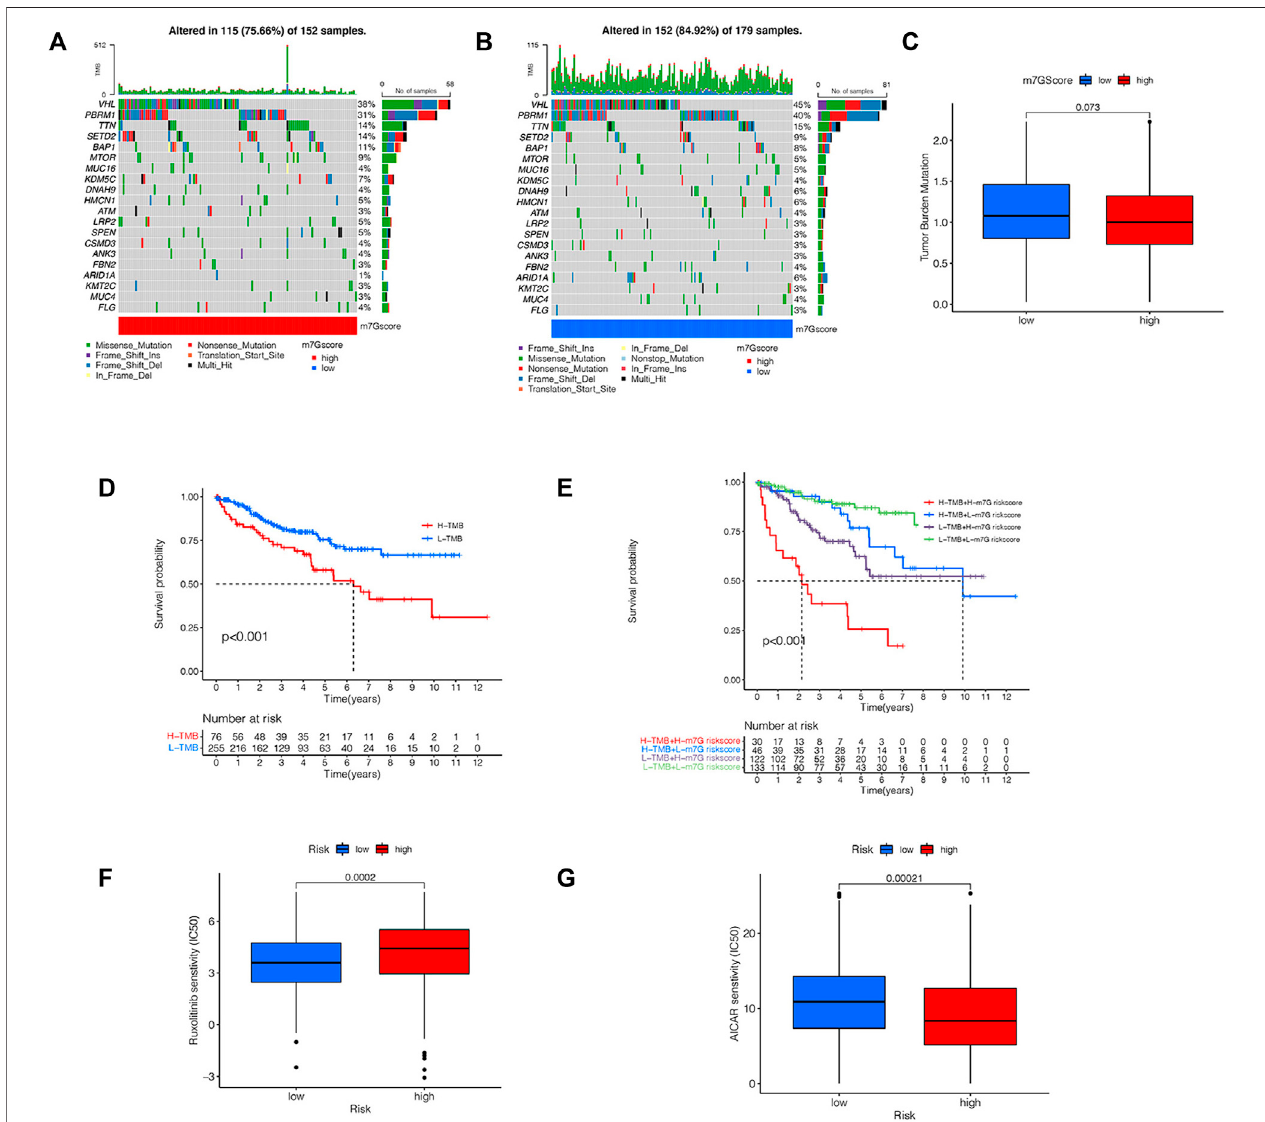
FIGURE 10 | Analysis of TMB and drug sensitivity. (A,B) The waterfall plot shows the somatic mutation characteristics of two risk groups. (C) Difference of TMB between two risk groups. (D) K-M survival analysis of high-TMB group and low-TMB group. (E) K-M survival analysis based on TMB and risk score. (F,G) IC 50 values of AICAR and Ruxolitinib in two risk